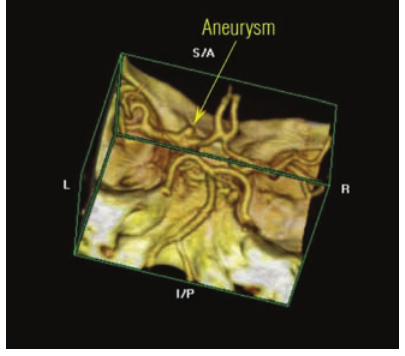
Figure 4. Computed tomography angiog- raphy showing an 18 x 10 mm and a 9 x 9 mm aneurysm at the right and left bifurca- tions of the internal carotid arteries,